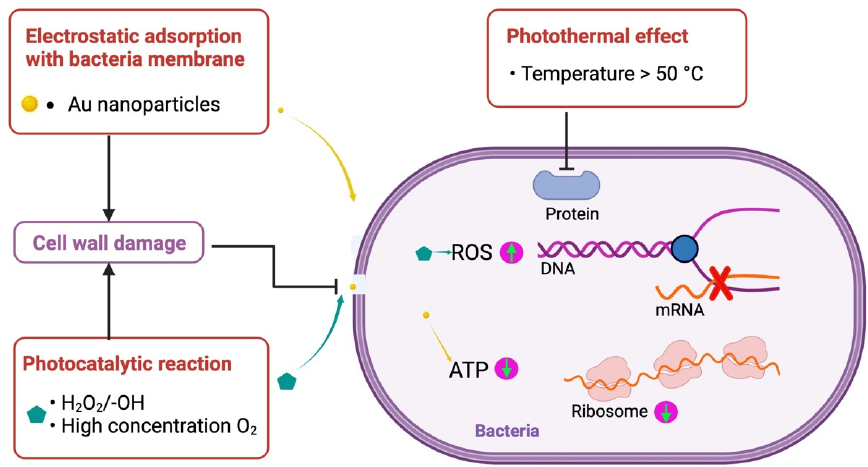
Figure 5. Schematic illustration of antibacterial mechanism of gold nanoparticles.